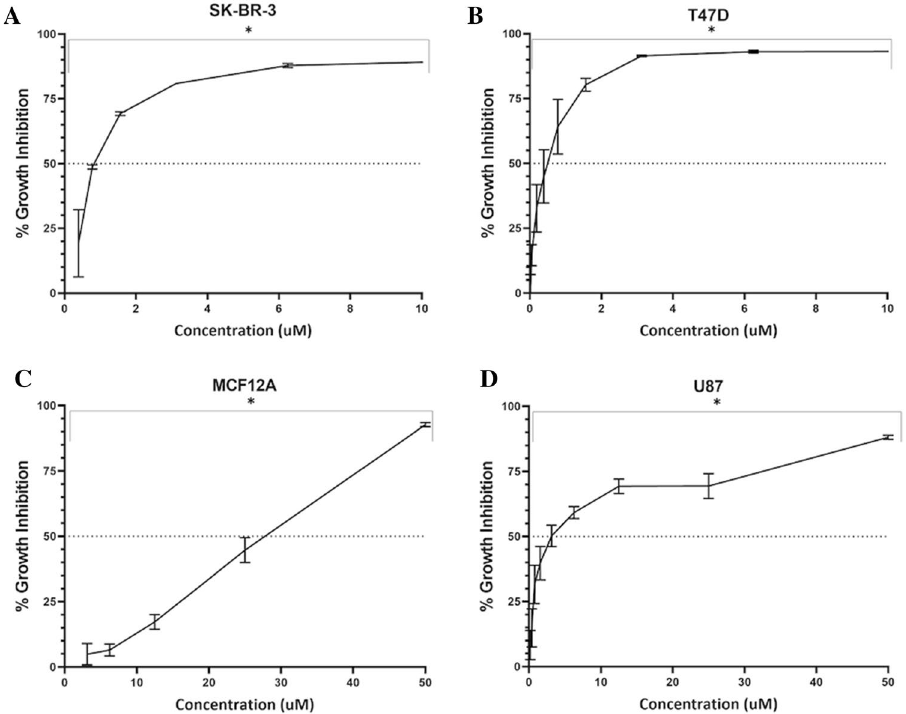
Figure 2. Anti-growth activity of Averufanin on additional cancer cell lines. Percent growth inhibition curves were characterized by NCI SRB assay on breast cancer (0.2–100 µM). The experiment was conducted in triplicate and absorbance values were normalized to DMSO negative controls. Significantly difference compared to DMSO treated cells (*p <